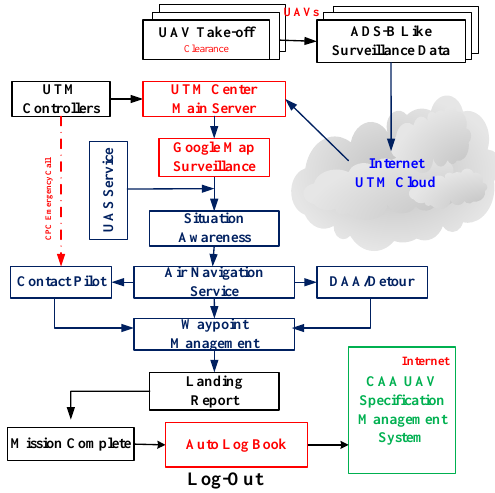
Figure 7. UTM in-flight and post-flight procedures.